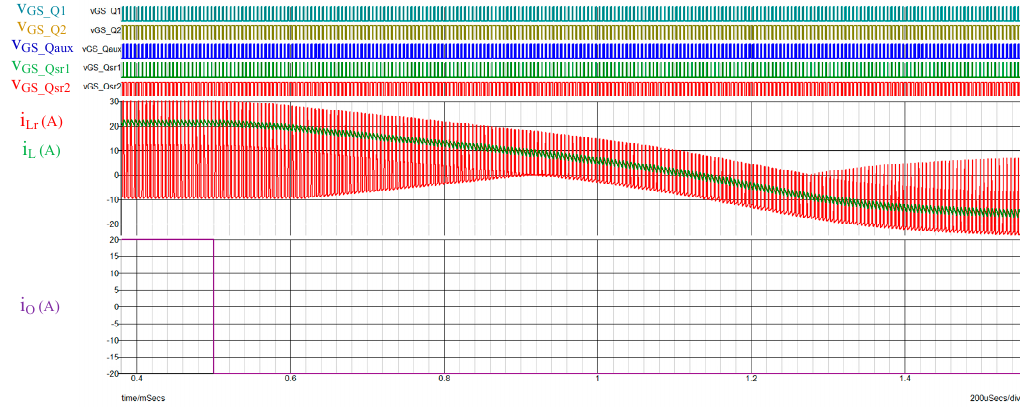
Figure 16. Simulation results: v GS waveforms of each switch, resonant inductor, output inductor current and output current waveform at V O = 50 V, Io = 20 A to − 20 A.